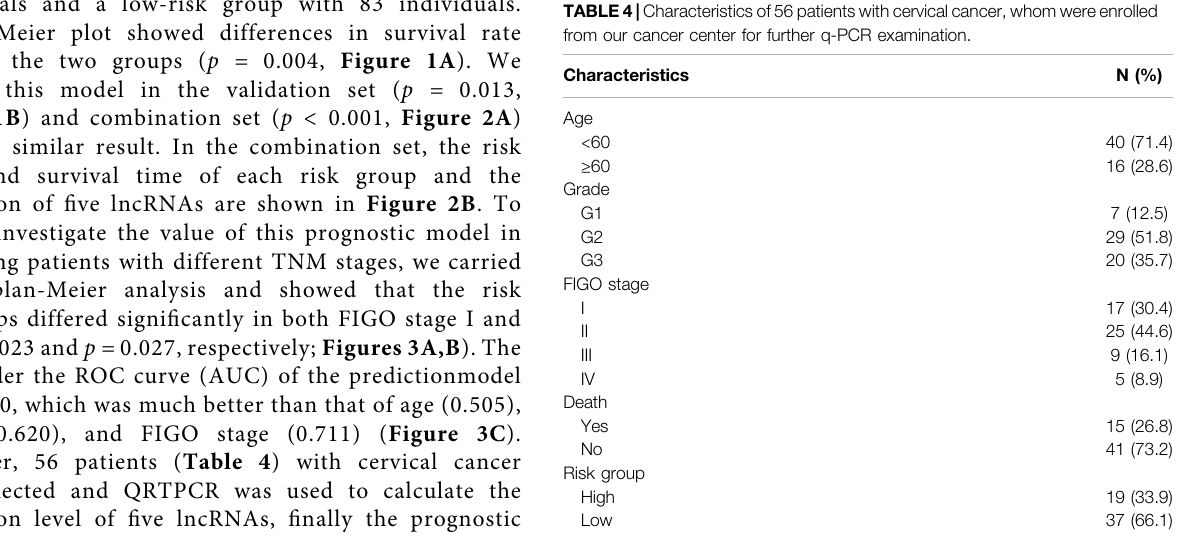
( Table 3 ). The expression level of lncRNAs and regression coef fi cient ( β ) were integrated to calculate the risk score for each patient. Based on the median risk score, we divided the patients from the training set into a high-risk group with 84 individuals and a low-risk group with 83 individuals.